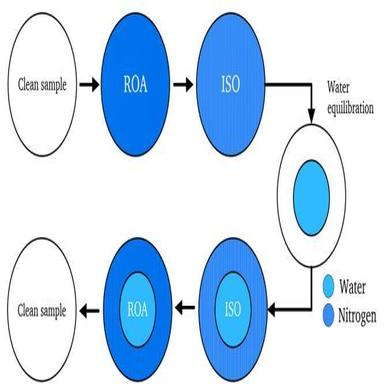
A schematic representation of the integrated nitrogen-water-nitrogen technique. ISO = isotherm,and ROA = rate of adsorption (not considered here).